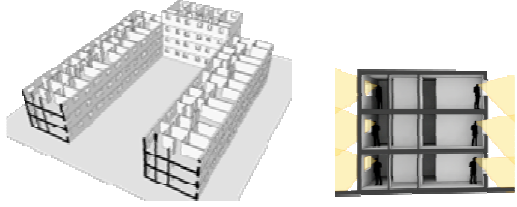
Figure 5: Existing interior space layout and functionality